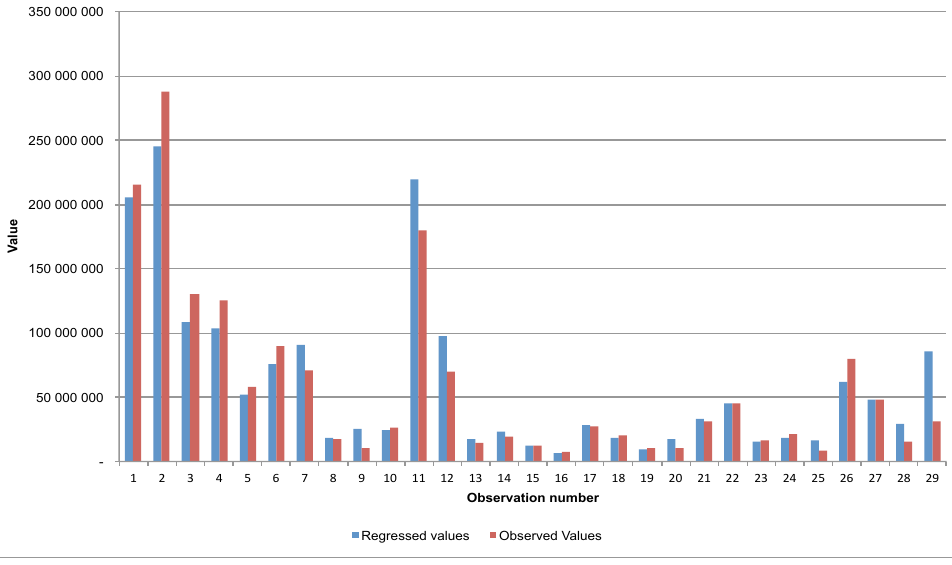
Investec property fund LREIV model regressed vs observed